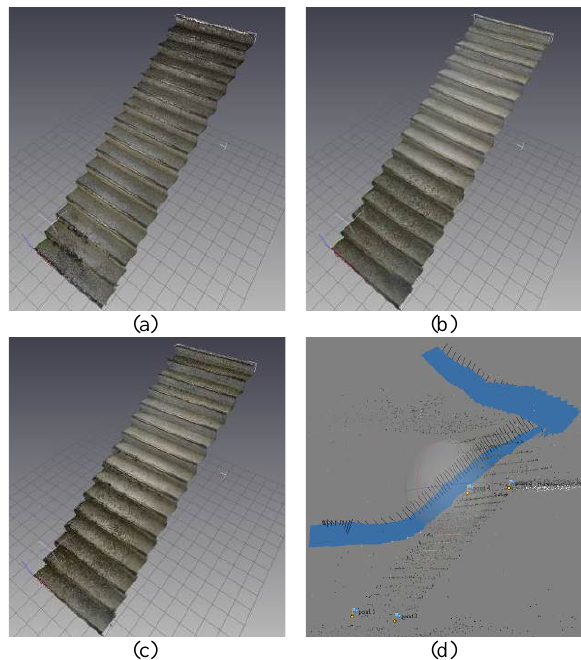
Figure 7. Results of a stair: (a) results of 12MP images; (b) results of 4K video; (c) results of 1080P video; (d) perspective centre of cameras for 1080P video.